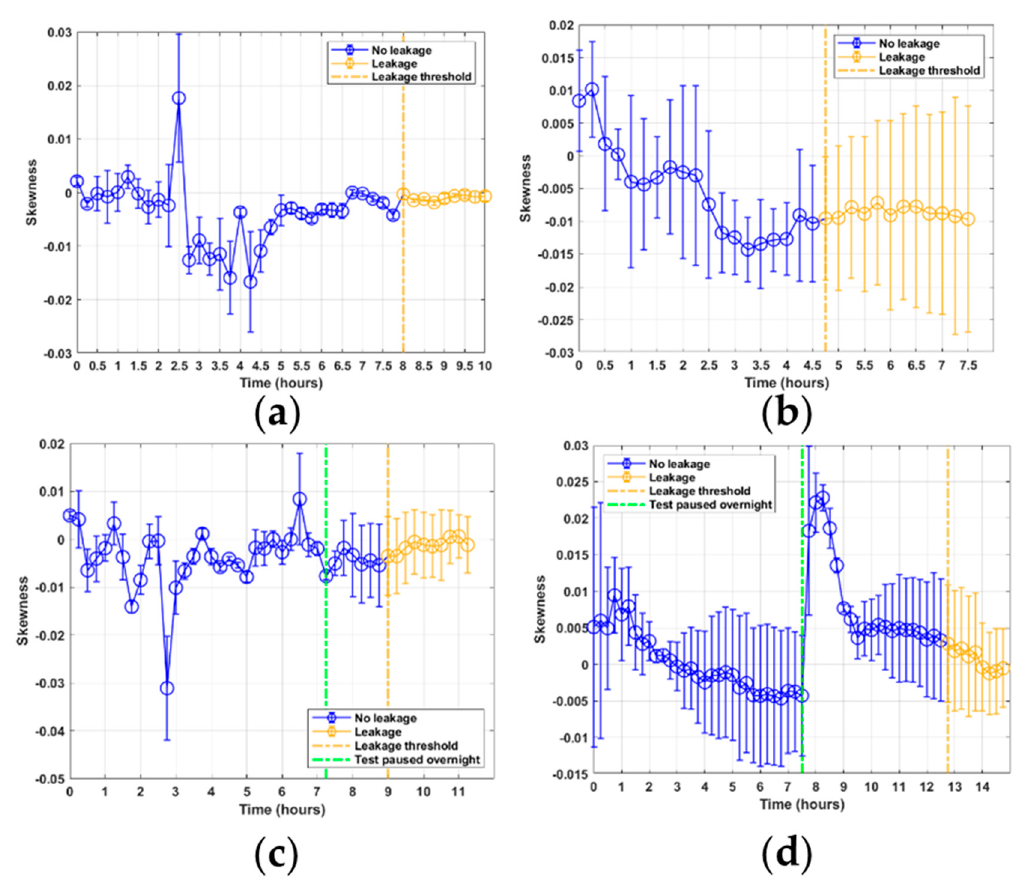
Figure 9. Skewness feature results from RTF tests 1–4: ( a ) test 1; ( b ) test 2; ( c ) test 3; ( d ) test 4.